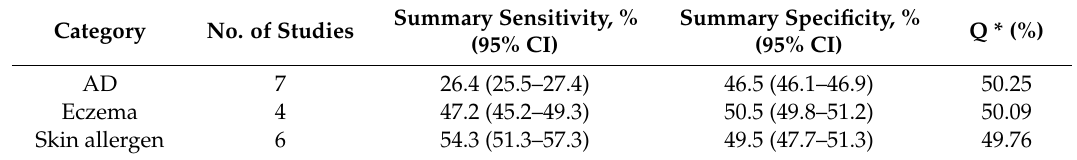
Table 6. Summary sensitivity and specificity of AD, eczema disease, and skin allergies due to PM.